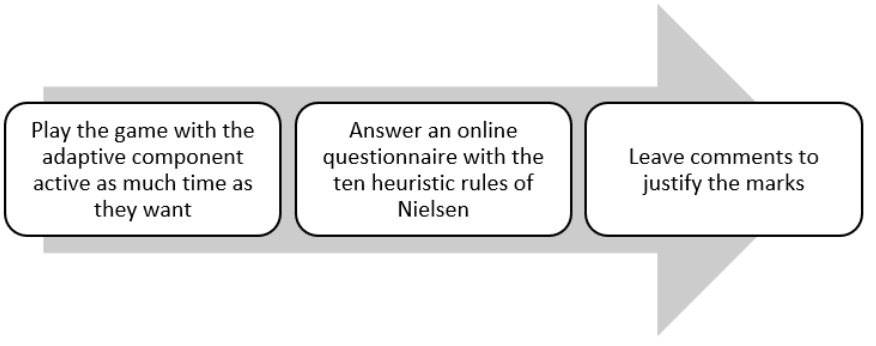
Figure 8. Description of the experiment procedure.